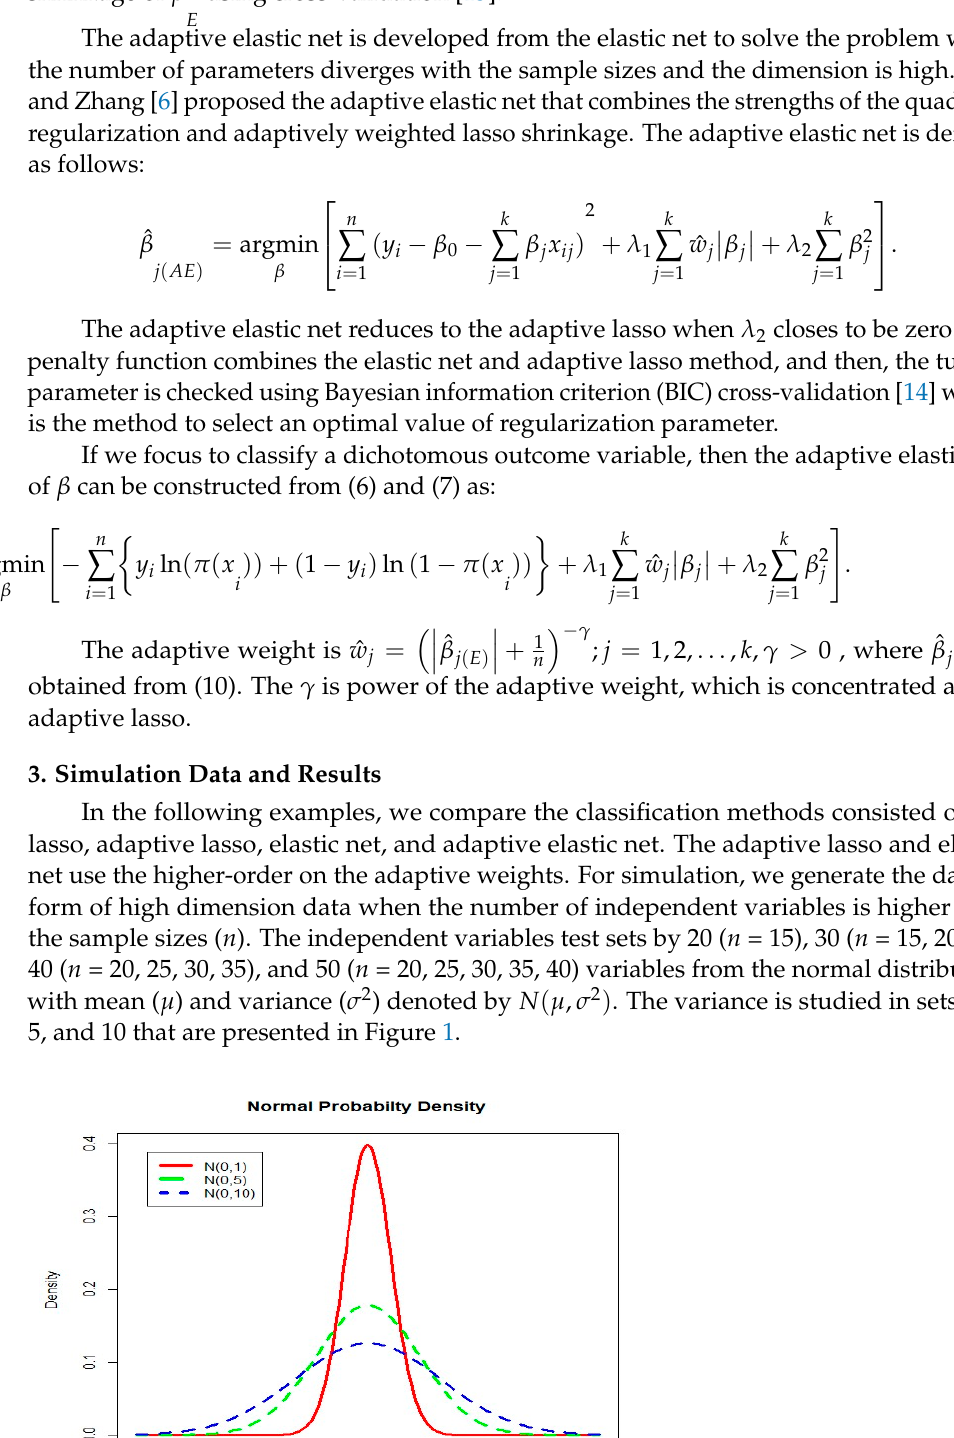
σ 2 = 1, 5, and = 1, 5, and 10. Figure 1. The normal probability density in µ = 0 and variance σ